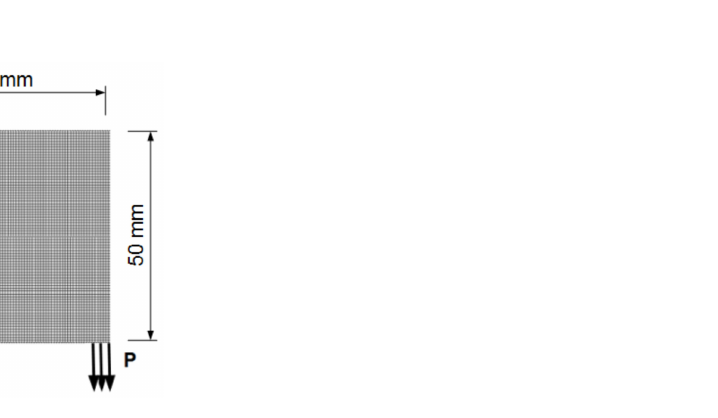
Figure 2. The square structure (50 × 50 elements) with applied loads and supports.